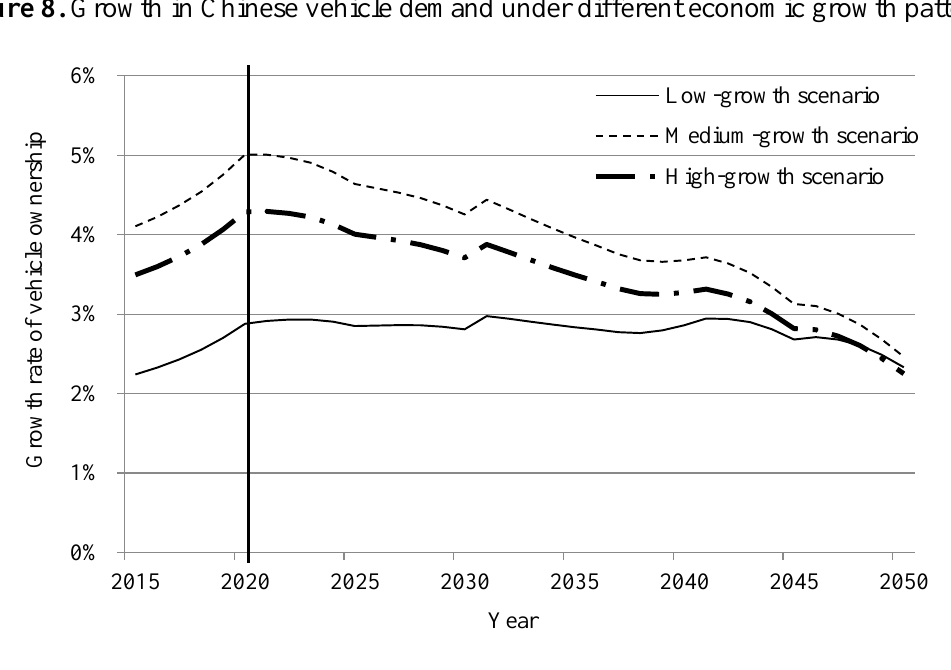
Figure 8. Growth in Chinese vehicle demand under different economic growth